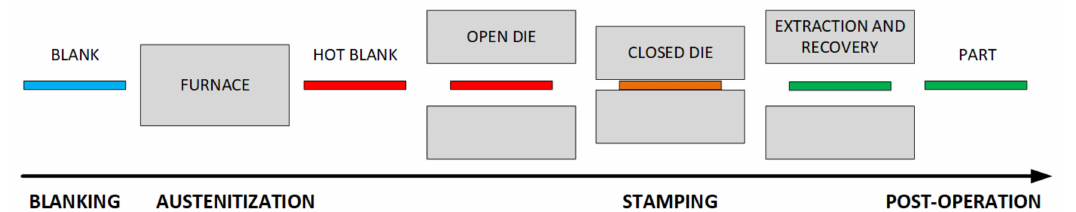
Figure 1. Hot stamping direct method process phases.